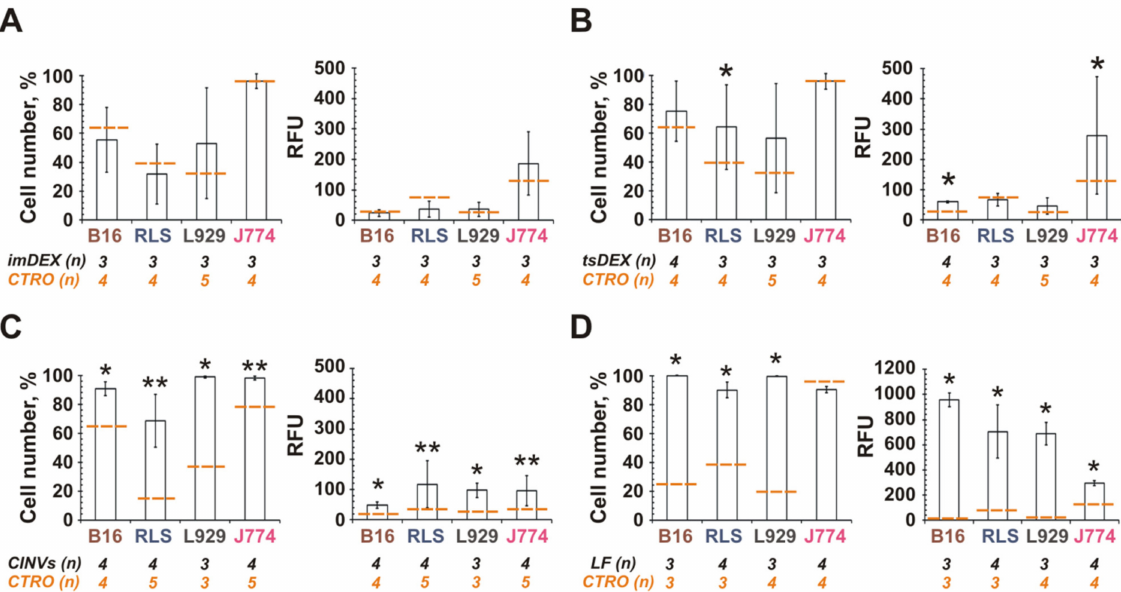
Figure 2. FAM-ON delivery into murine cells mediated by DC-derived EVs or CINVs. Fifty micrograms of FAM-ON loaded imDEX ( A ), tsDEX ( B ) or tsDC CINVs ( C ) were incubated with B16, RLS, L929, or J774 cells. ( D )–FAM-ON delivery mediated by Lipofectamine 2000 (LF). Cell number is the percentage of FAM-positive cells in a population. RFU is relative fluorescence units detected in a cell population. The level of FAM-ON self-penetration into the cells (CTRO) is shown by an orange dashed line. The number of measurements is indicated as n . Experimental data are presented by white columns as the mean ± SD. Statistical analysis was performed using the Mann–Whitney U test and was carried out between the experimental group ( n = 3–4) and CTRO ( n = 3–5); * p ≤ 0.05, ** p ≤